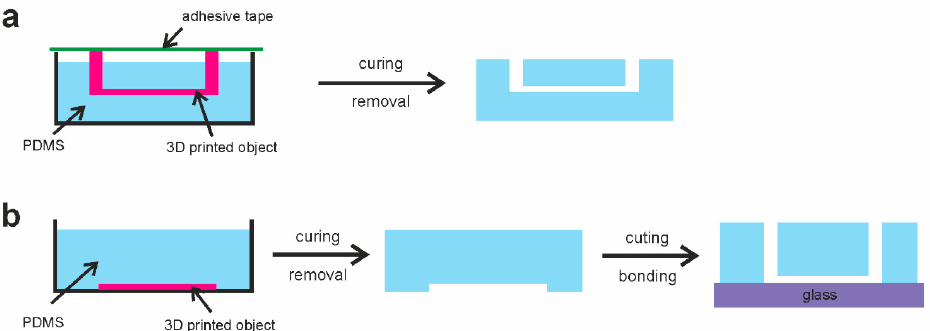
Figure 1. Design of PDMS-based microdevices using 3D-printed scaffold removal: ( a ) monolithic microdevices; ( b ) bonded microdevices.